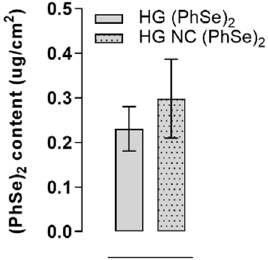
Figure 4. In vitro permeation study in vaginal mucosa after the application of hydrogels. The statistical evaluation was performed by unpaired Student’s t ( p > 0.05).